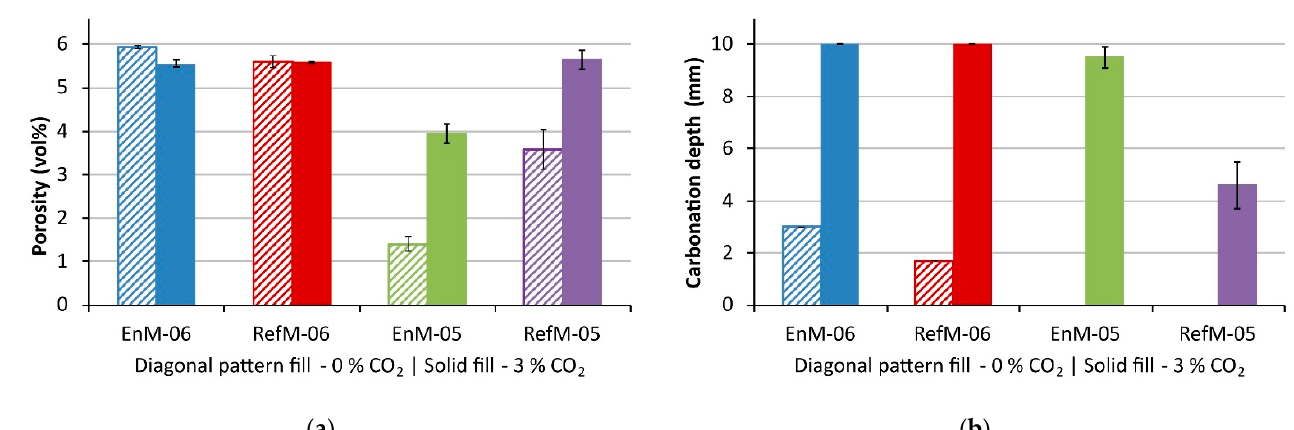
Figure 8. Total porosity ( a ) measured according to SIA 262-1 [23]; and carbonation depth ( b ) of conditioned specimens after stage 5. Specimens in the group “3%” were exposed to a 3.1% CO 2 atmosphere, while specimens in the group “0%” were exposed to the atmosphere with reduced CO 2 content. “EnM” and “RefM” stand for EnDurCrete and reference mortar, respectively, while extensions “-06” and “-05” refer to water/cement ratios of 0.6 and 0.5. The error bars indicate the variation in values measured on the three